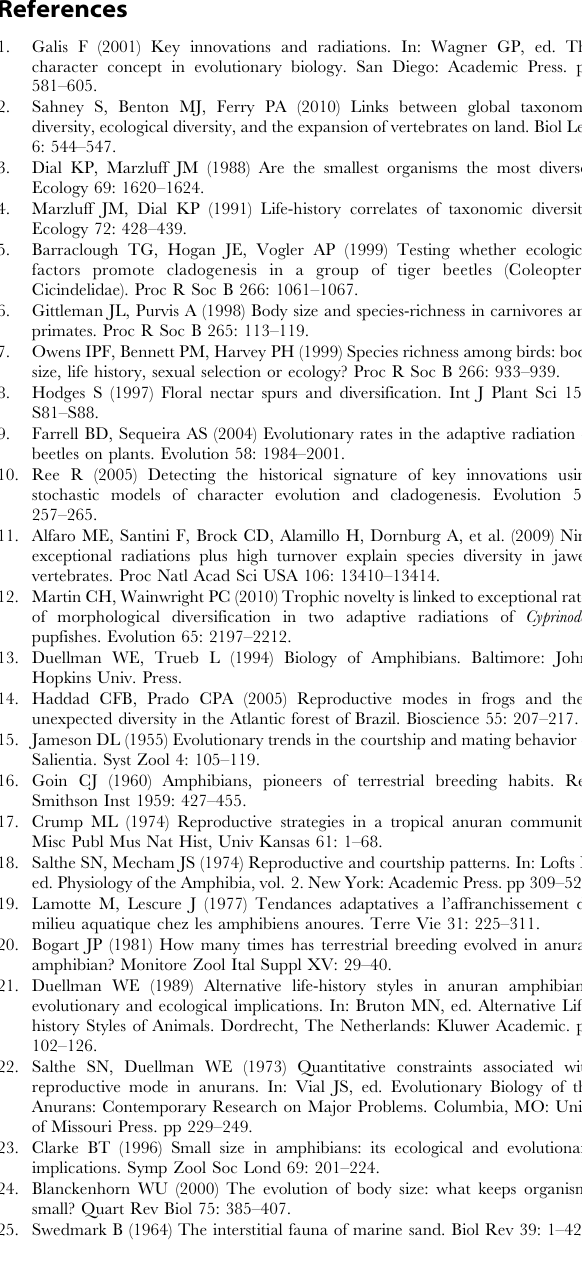
Table S1 Specimens examined, including snout-vent length (SVL) and pedal webbing. Table S2 Known reproductive modes of species includ- ed in this